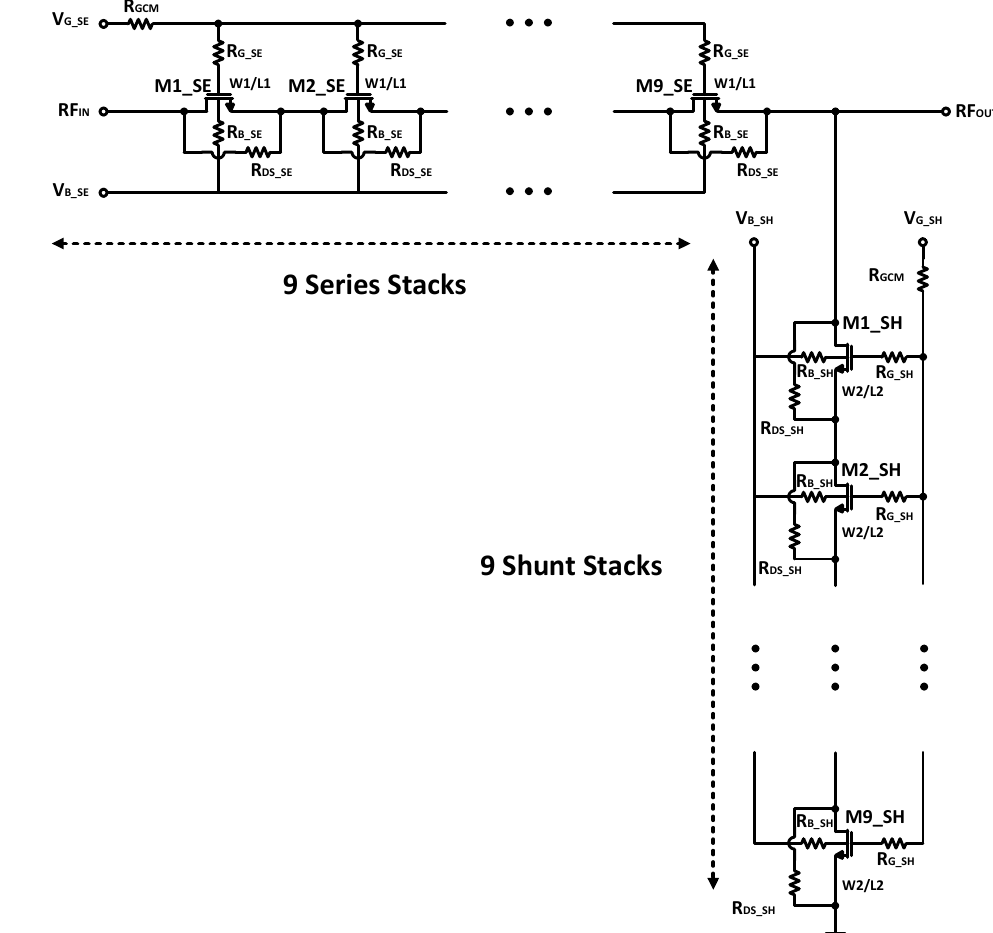
Figure 7. The proposed RF switch arm with 9 series stacks and 9 shunt stacks with a linearity en- hancement design. enhancement